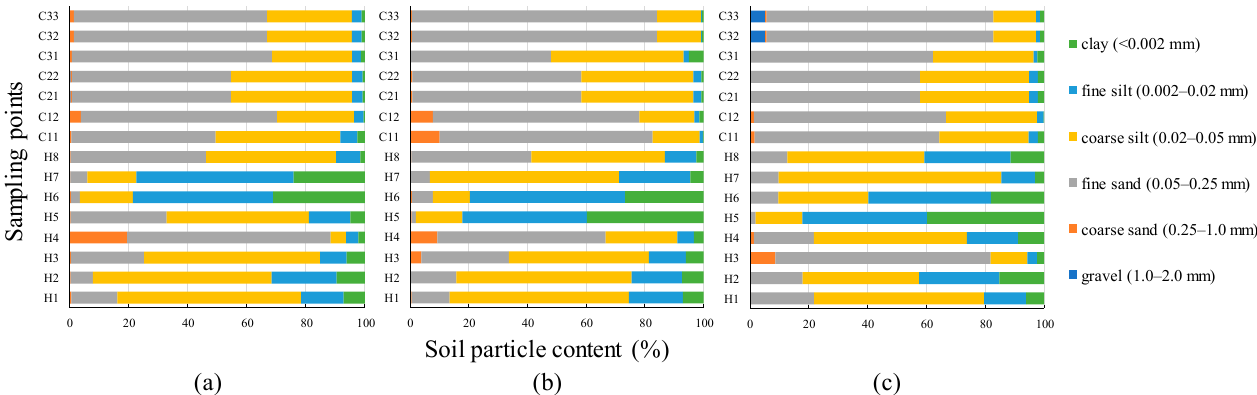
Figure 3. Photos of soil sampling.